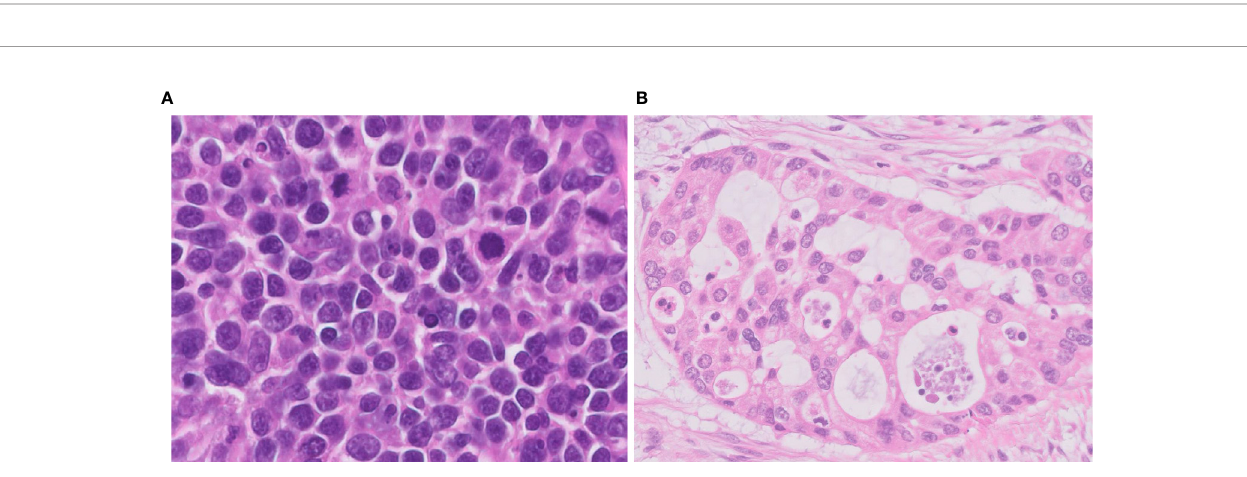
FIGURE 1 | Morphology of neuroendocrine tumors of the lung. (A) Typical carcinoid shows solid nests with zellballen patterns; the tumor cells are uniform with a moderate amount of eosinophilic cytoplasm. (B) Atypical carcinoid with rosette formation. (C) SCLC showing sheets of small cells with scant cytoplasm, fi nely granular chromatin, and mitoses. (D) LCNEC displays organoid nesting and palisading patterns; tumor cells have abundant eosinophilic cytoplasm, coarsely granular chromatin, and prominent nucleoli. Magni fi cation: ×40.